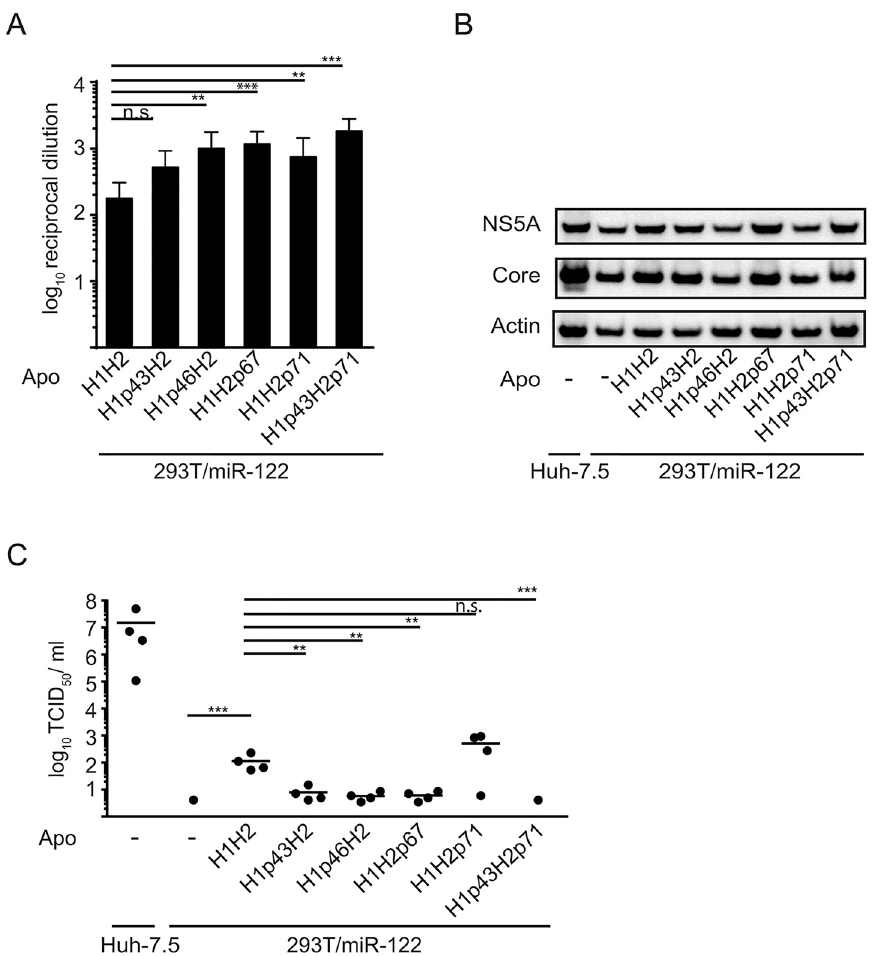
Fig 7. Amphipathic alpha-helices in ApoC1 are key determinants for HCV assembly. A: Secretion wild- type ApoC1 (H1H2) and five mutants with proline insertions to disrupt formation of the first helix (H1p43H2 and H1p46H2) or the second helix (H1H2p67 and H1H2p71), or both helices (H1p43H2p71) were quantified by HA- specific ELISA. Depicted are average values of 3 independent experiments with reciprocal dilutions of ApoC1 constructs that reach an OD of 2-fold over background. Significant changes compared to wild-type ApoC1 are indicated based on Dunnetts ’ multicomparison test. ( *** = p < 0.01, ** = p < 0.01, n.s. = non-significant (p > 0.05)) B: Cells transfected with HCV RNA (Jc1 wt) and expression of viral and cellular proteins was determined by Western blotting using antibodies specific for core, NS5A and ß-actin. C: Absolute values of viral infectivity were determined by end point dilution assay. Plotted are individual results of four independent experiments with means presented as a dash. Data were analyzed by Dunnett ’ s multicomparison test. ( *** = p < 0.01, ** = p < 0.01, n.s. = non-significant (p >